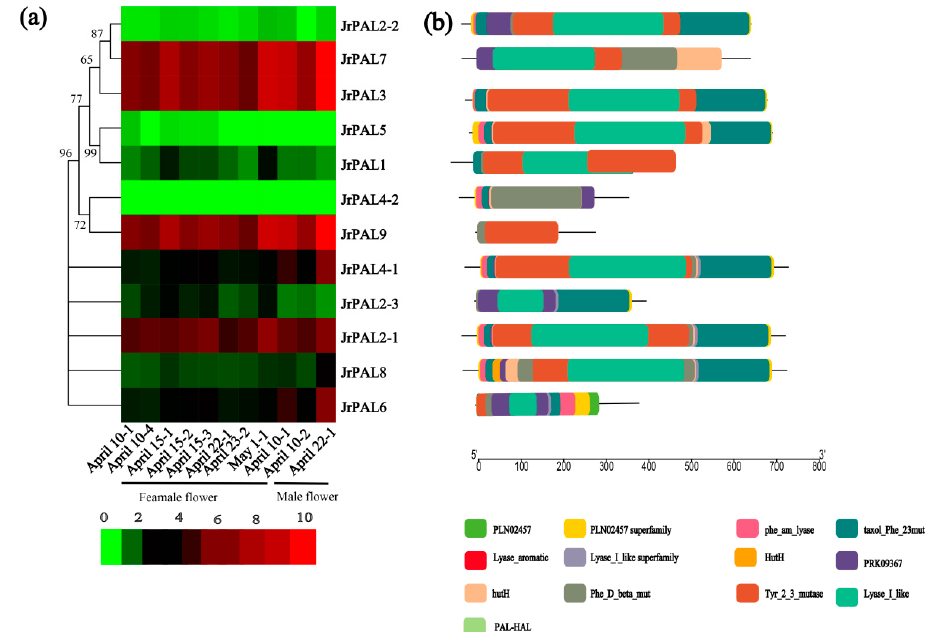
Figure 6. ( a ) Phylogenetic relationships and expression patterns and ( b ) conserved motif